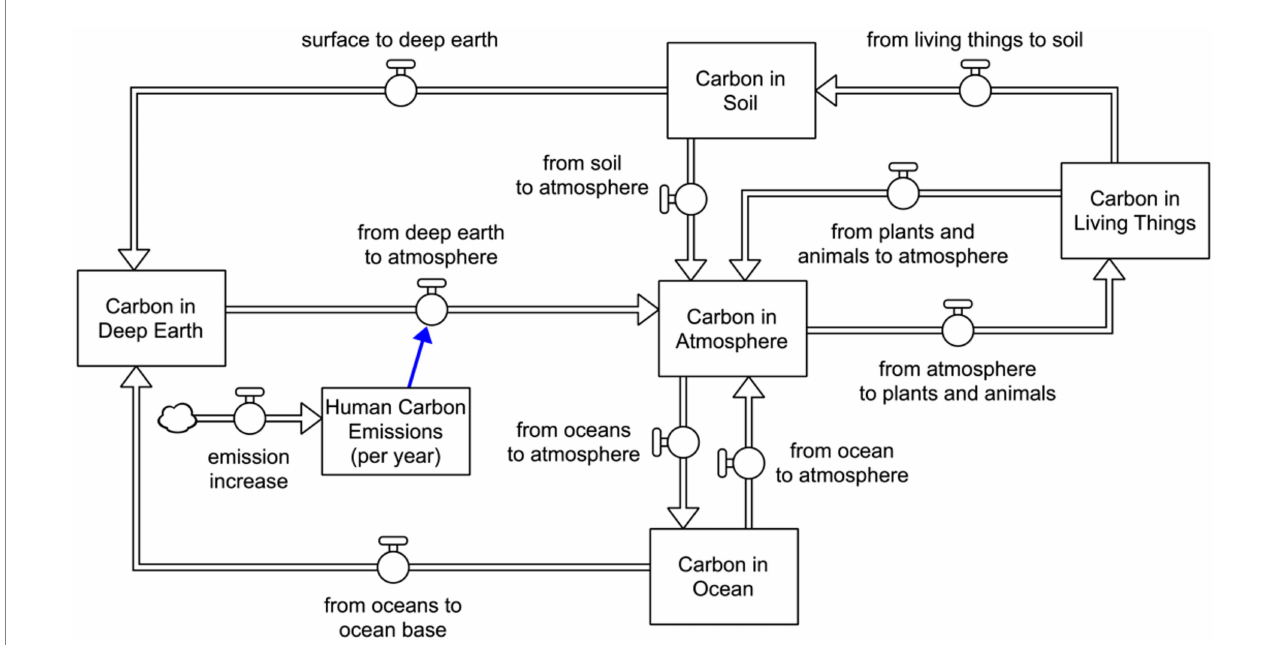
FIGURE 6 The Stock-Flow map of the basic stocks of the carbon